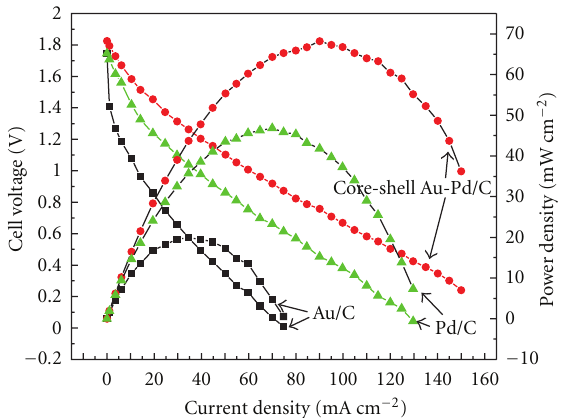
Figure 8: Cell polarization curves and power density curves of the DBHFC using various anode